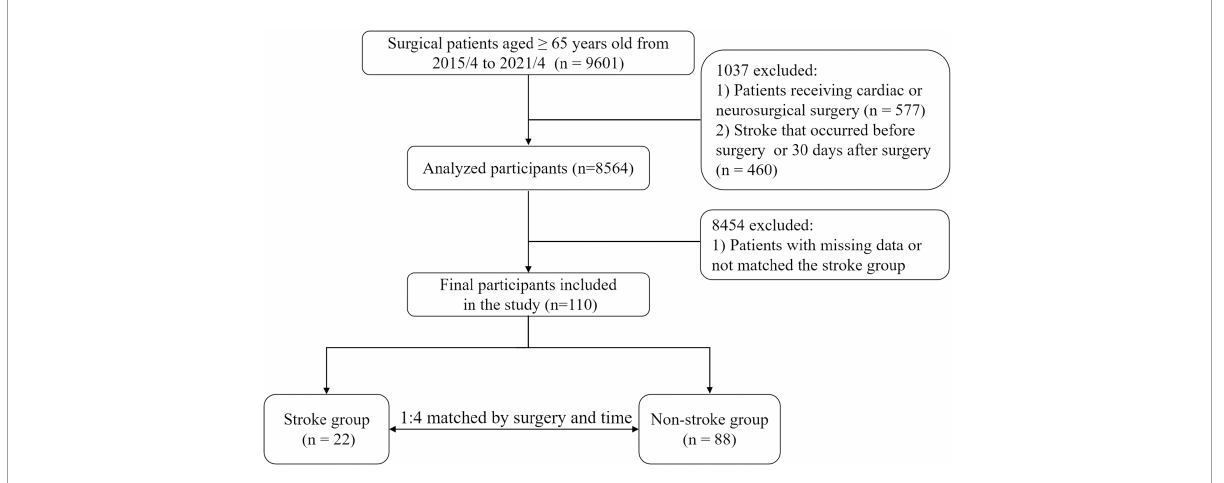
FIGURE1 Study flowchart. The stroke diagnosis of each patient, both in the case and control groups, was re-confirmed by a neurologist and an